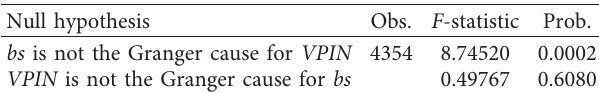
Table 7: Granger causality test results for IH dominant